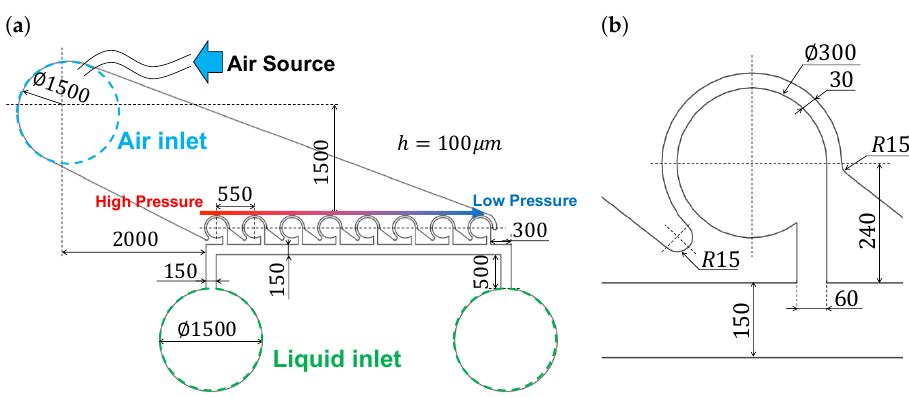
Figure 2. Design of the microchip. ( a ) Overall dimensions of flow channel. Air pressure is supplied from the air source. Arrow above the driving chamber indicates the expected pressure supplied to the driving chamber. ( b ) Detailed dimensions of the main chamber, which were determined on the basis of previous studies